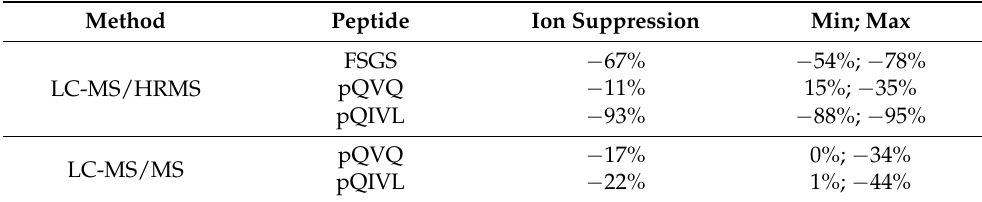
Table 7. Matrix effect calculated from six human plasmas spiked at 50 µ g/mL (LC-MS/HRMS), or four human plasmas spiked at 15 and 300 µ g/mL